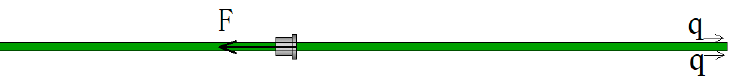
Figure 10. Onsite testing.